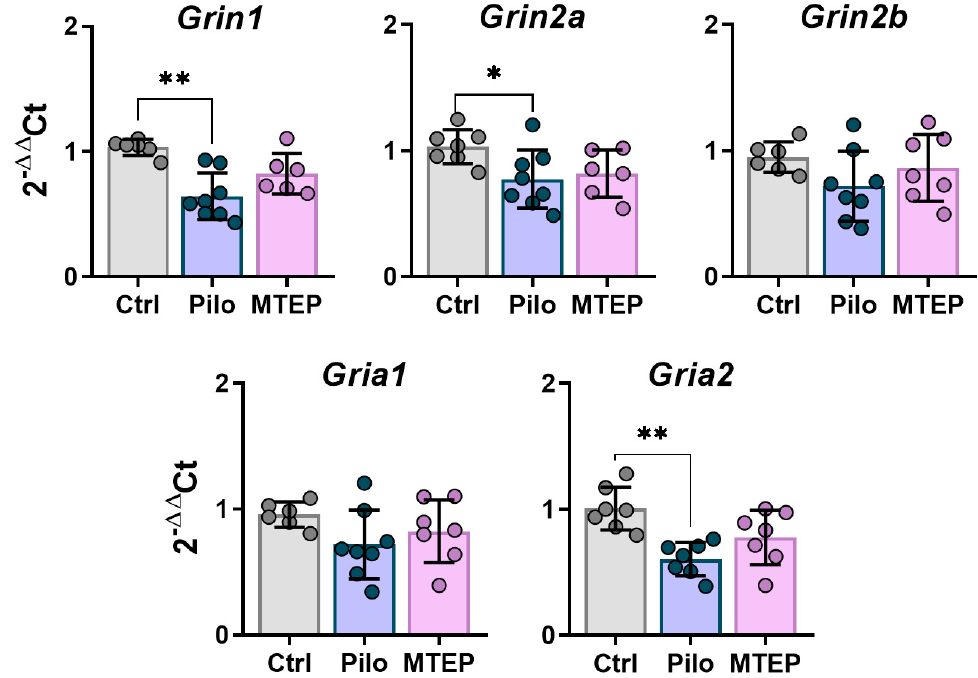
Figure 8. The relative expression of genes of NMDA and AMPA receptor subunits in the dorsal hippocampus 7 days after pilocarpine-induced SE. Subunit genes: Grin1 –GluN1, Grin2a –GluN2a, Grin2b –GluN2b, Gria1 –GluA1, Gria2 –GluA2. Each dot represents one animal; the bars indicate average values and error bars show standard deviations. One-way ANOVA, Grin1: F 2,19 = 11.8, p < 0.001; Grin2a: F 2,20 = 3.7, p < 0.05; F 2,20 = 1.7, p = 0.2; Gria1: F 2,20 = 1.8, p = 0.2; Gria2: F 2,20 = 9.1, p < 0.01. Asterisks indicate significant differences between groups according to Tukey’s post hoc tests: * p < 0.05; ** p < 0.01.